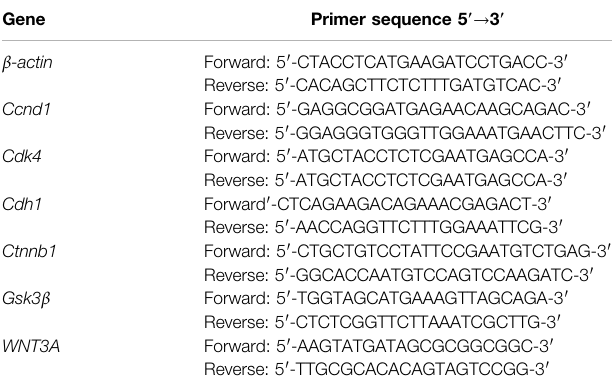
TABLE 1 | Primers used for the quantitative